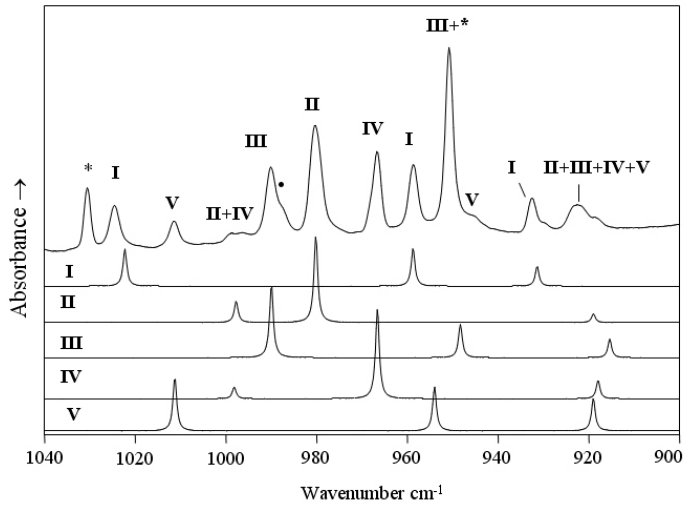
Figure 5. IR absorption spectrum of 1-butene SOZ isolated in N matrix (top). Theoretically calculated spectra of five most stable conformers 2 in the spectral region of the ring vibrations. Asterisk (*) denotes spectral bands of ethene SOZ, (•) denotes impurity spectral